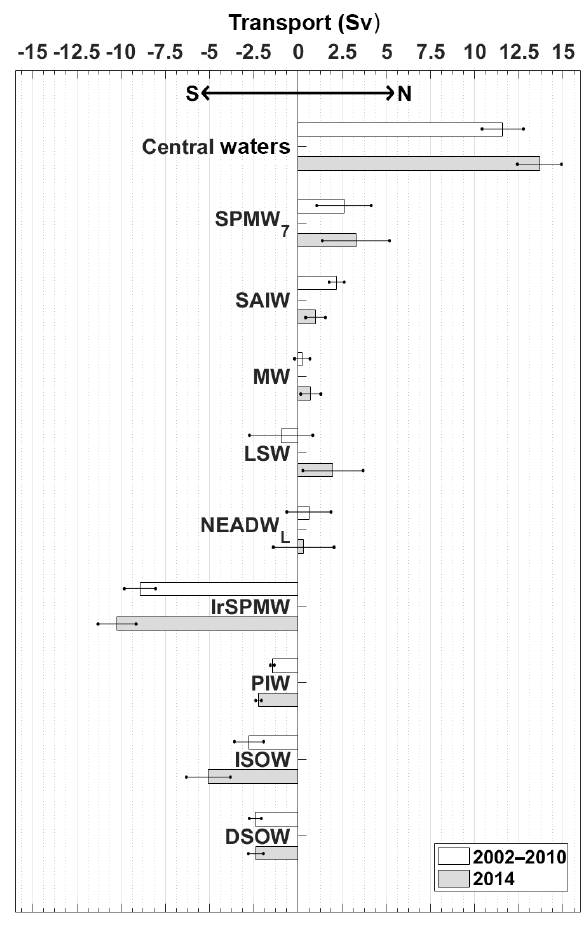
Figure 5. Net water mass volume transports (in Sv; 1Sv = 10 6 m 3 s − 1 ) perpendicular to the OVIDE line for the 2002–2010 period (white bars; from García-Ibáñez et al., 2015) and for 2014 (grey bars). Transports are positive (negative) northwards (southwards). Central Waters refers to the sum of ENACW 16 , ENACW 12 and SPMW 8 ; and SAIW to the sum of SAIW 6 and SAIW 4 (consult Table 1 for water mass acronyms). Error bars represent the error in the net water mass volume transport for 2014 and the standard deviation from the average net water mass volume transport for